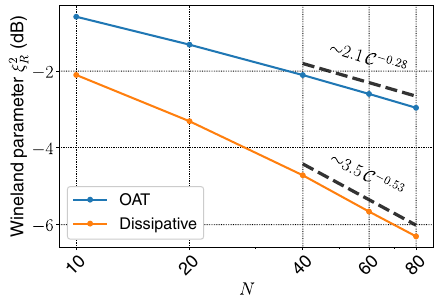
FIG. 5. A comparison of the Wineland parameter ξ 2 between R the dissipative (blue) and OAT (orange) protocols as a function of N for a small number of spins. The simulations are performed by evolving the spin-only quantum master equation [see Eq. (11) for the case of dissipative protocol, and Appendix G for the details on OAT]. In the dissipative protocol, at each value of N , both r as well as κ are optimized, while in the case of OAT, the sqz optimization is performed over the cavity-spin detuning. The 0 . 02 g and κ 100 g , parameters used in both cases are γ rel ¼ int ¼ 2 . The two dashed resulting in single-spin cooperativity of η rel ¼ lines show fits of the last few data